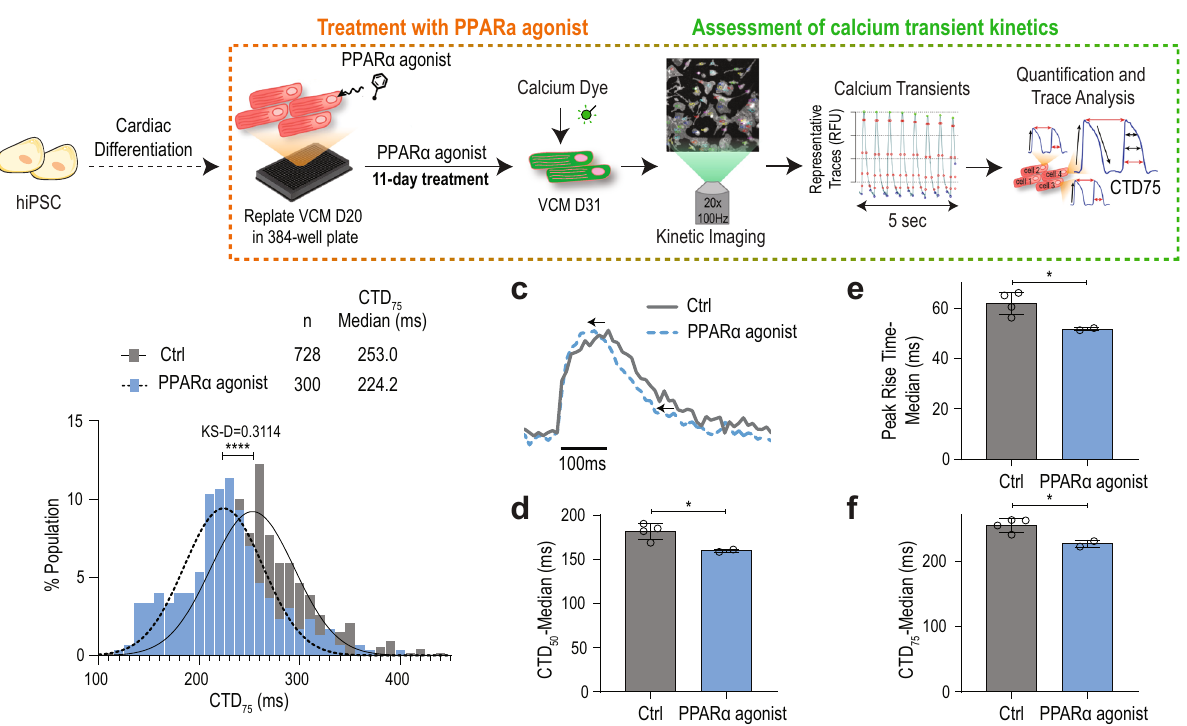
Fig. 6 PGC1/PPAR activation improves calcium handling in PSC-CMs. a Experimental diagram of human PSC-CM differentiation, agonist treatment, and calcium function analyses. b Distribution of calcium transient duration (CTD) 75 of single ESC-CMs shows a shorter CTD75. c Sample calcium transient trace for control (gray) and PPAR α agonist (dashed blue) groups. d – f median peak rise ( p -value = 0.039), CTD 50 ( p -value = 0.034), and CTD 75 ( p -value = 0.026) times. control n = 728, PPAR α agonist n = 300 cells, p -values: *<0.05, ****<0.001. The student ’ s t -test was used. Error bars represent the standard